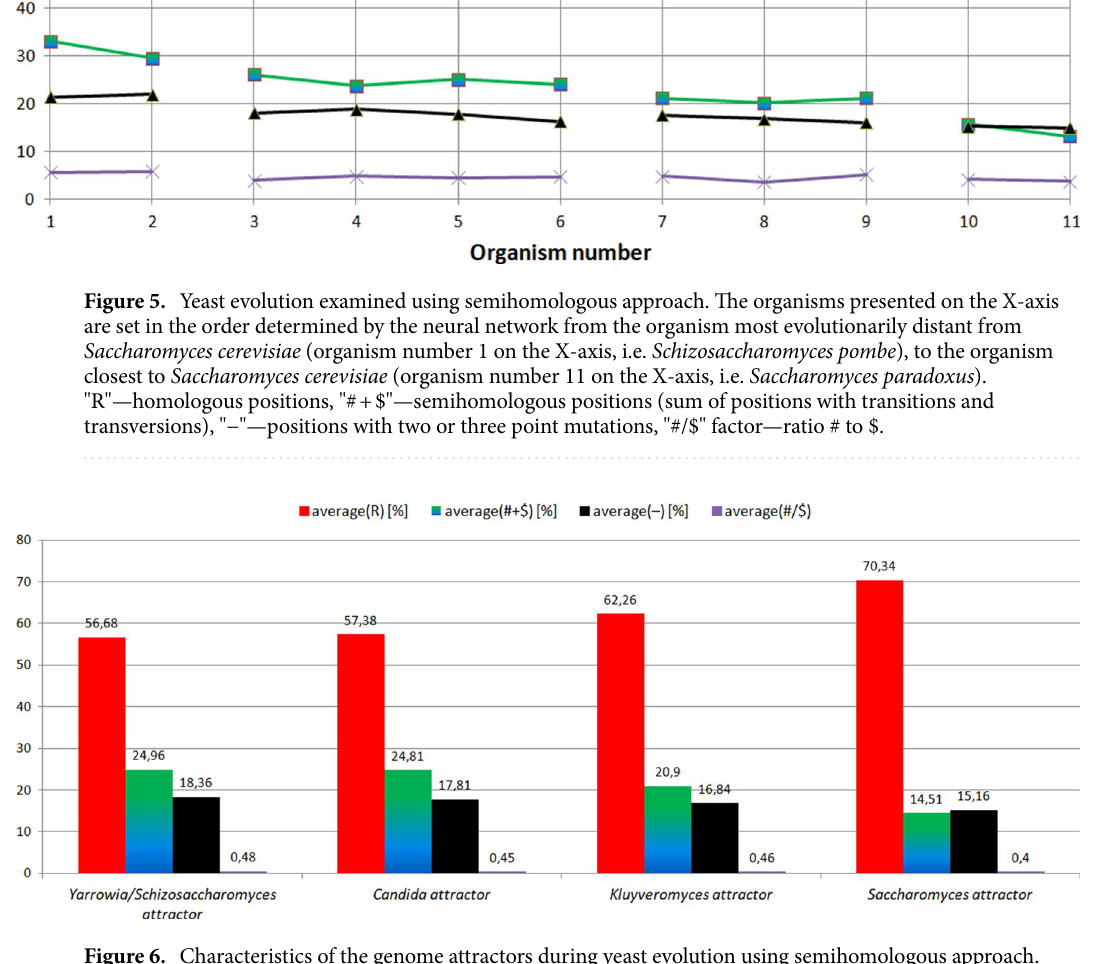
Figure 6. Characteristics of the genome attractors during yeast evolution using semihomologous